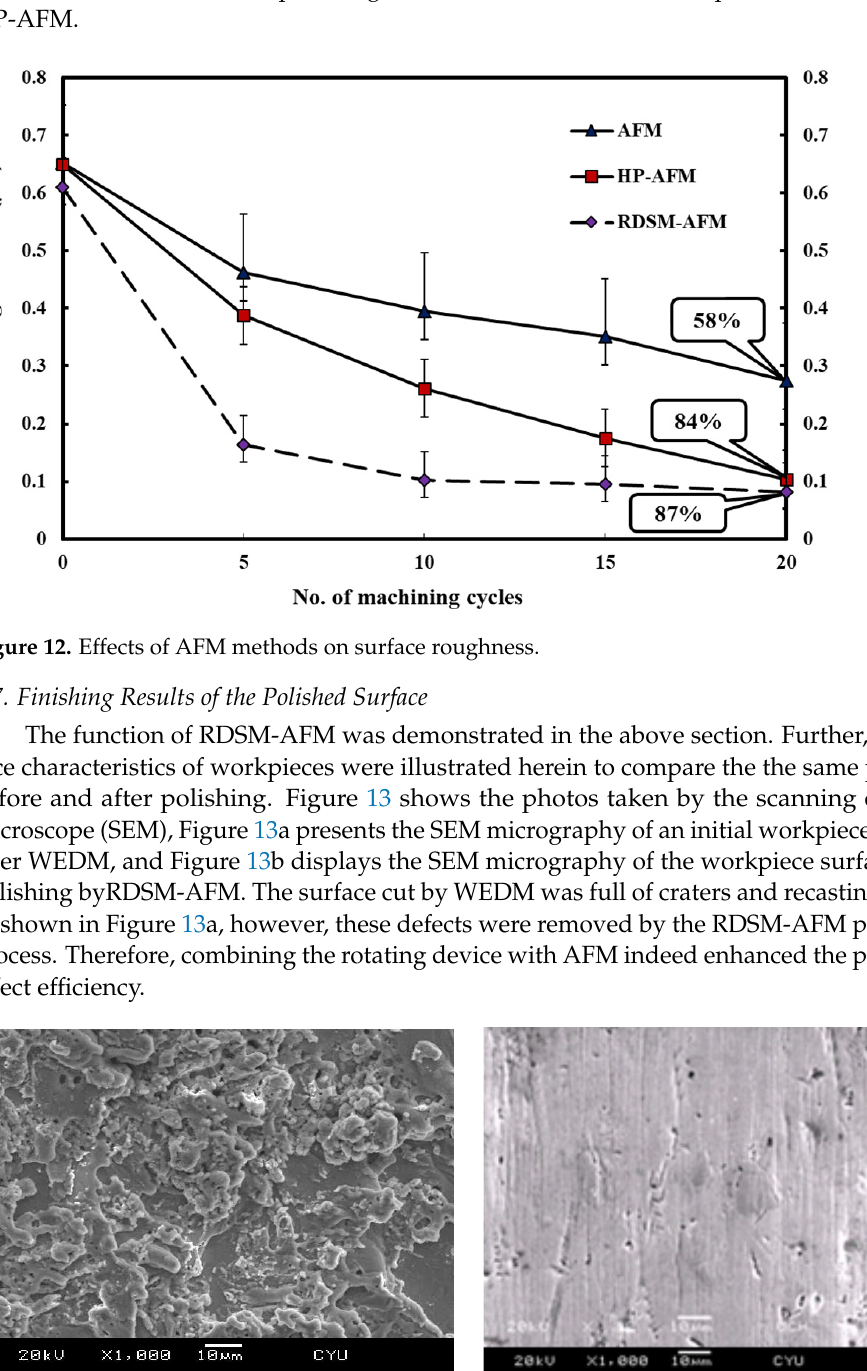
Figure 13. Thecharacteristics of SEM micrography (×1000) of the workpiece surface: ( a ) SEM photo during WEDM; ( b ) SEM photo after polishing by RDSM-AFM.